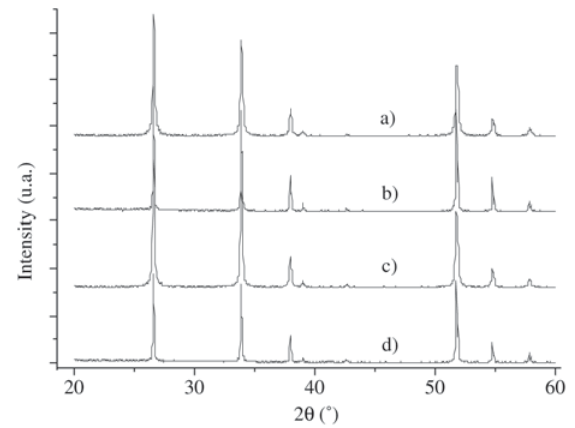
Figure 2. Linear shrinkage rate as a function of temperature for the concentrations of Nb ( ∇ ) 0.15%; and ( (cid:123) )